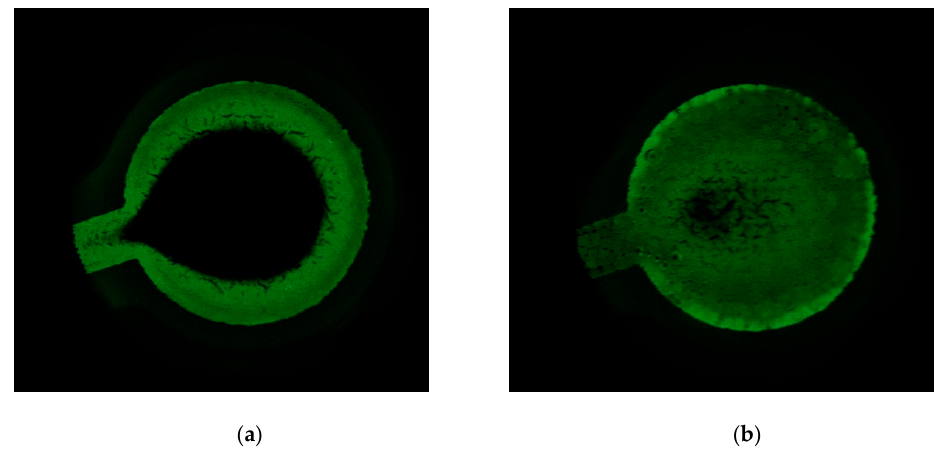
Figure 4. Long-exposure photographs, exposure time 1 s. − 46 V, 31.5 µC, frequency 50 Hz. ( a ) 3 s and ( b ) 29 s after the beginning of the excitation with 0.01 NaN 3 in 0.05 M Na 2 B 4 O 7 , 0.1 M Na 2 SO 4 . RS EC-